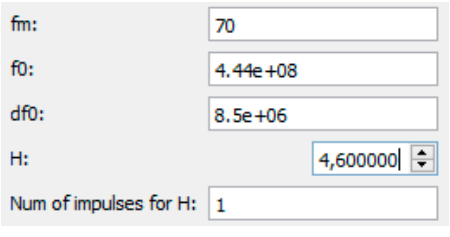
Figure 9. Application control panel.